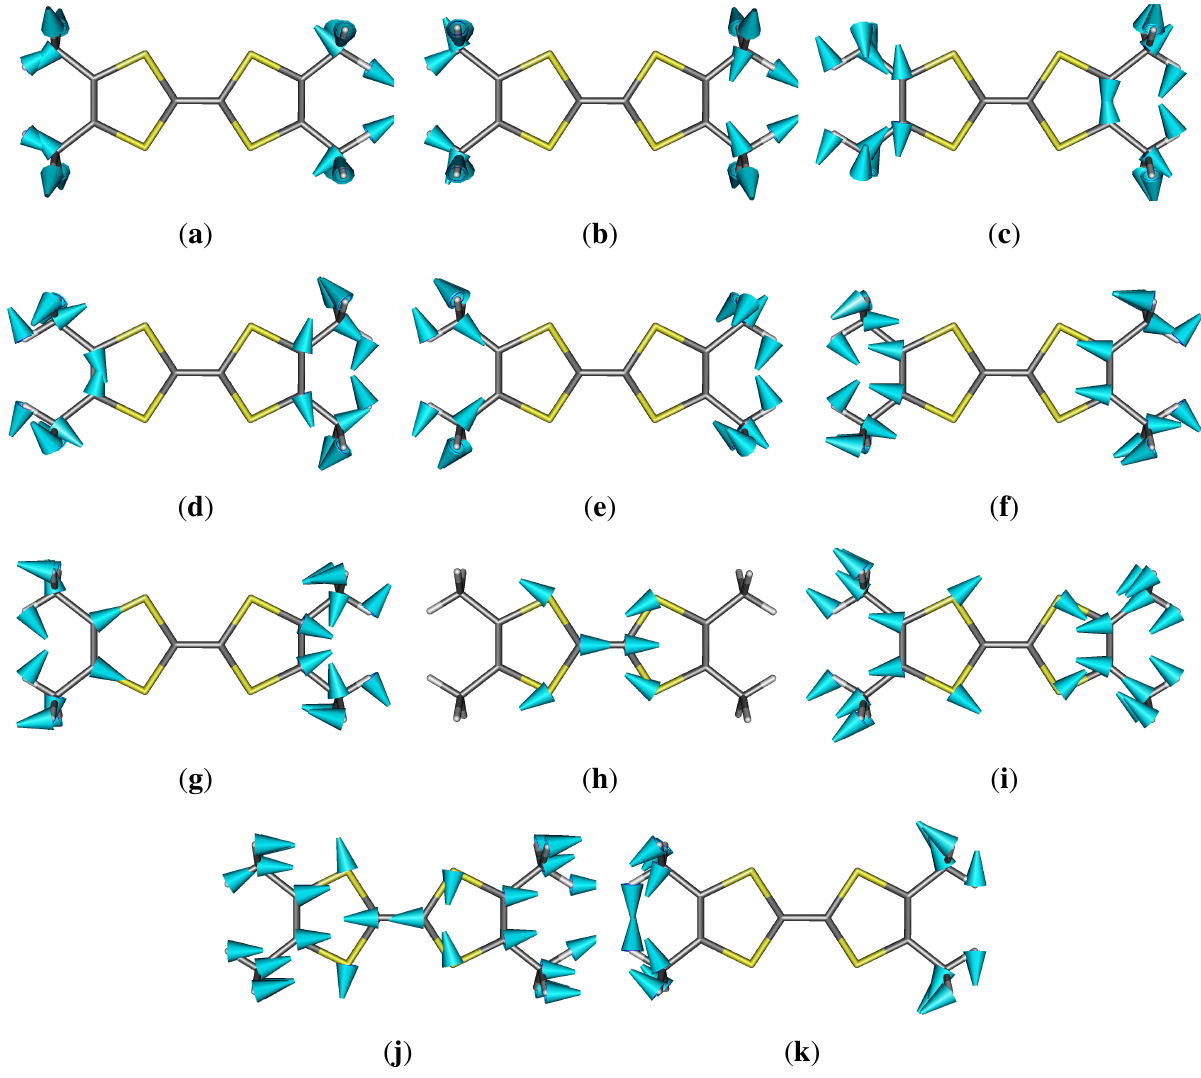
) intramolecular modes of 1 u